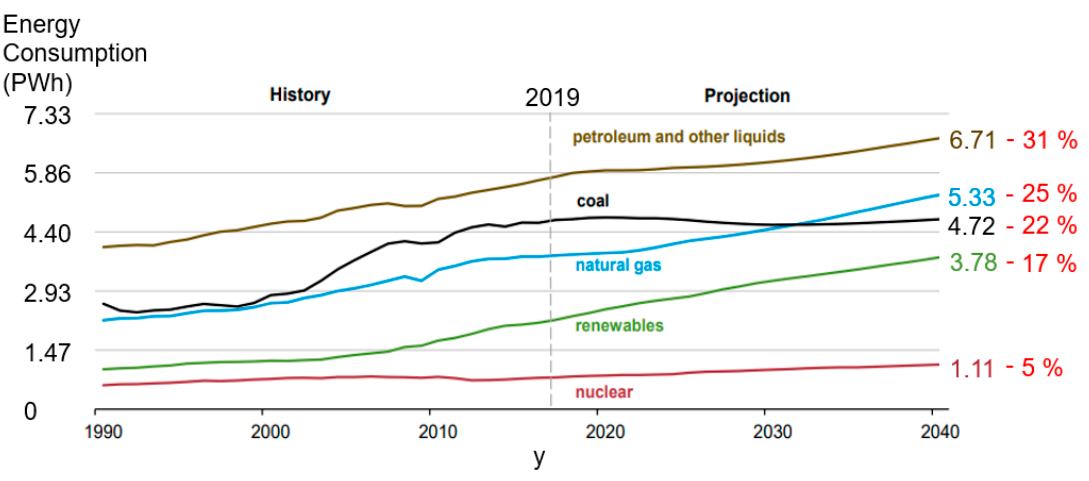
Figure 1. Global energy consumption for different fuels adapted from Capuano [5].